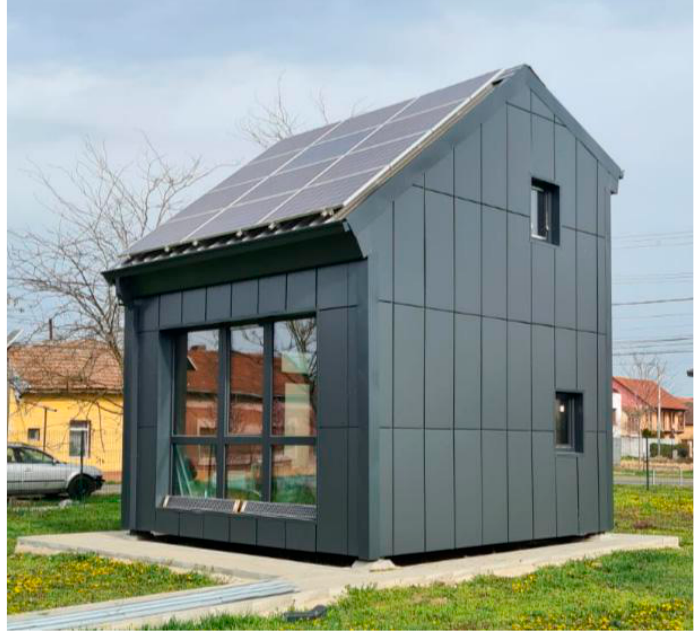
Figure 7. LSF experimental module.